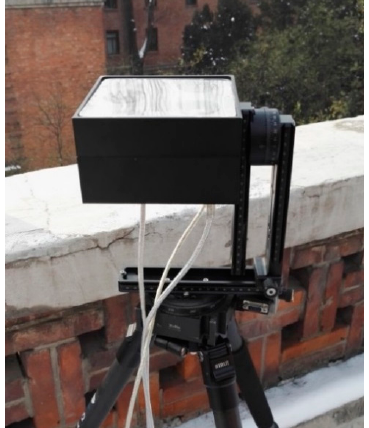
Figure 7. Image acquisition unit of the system.